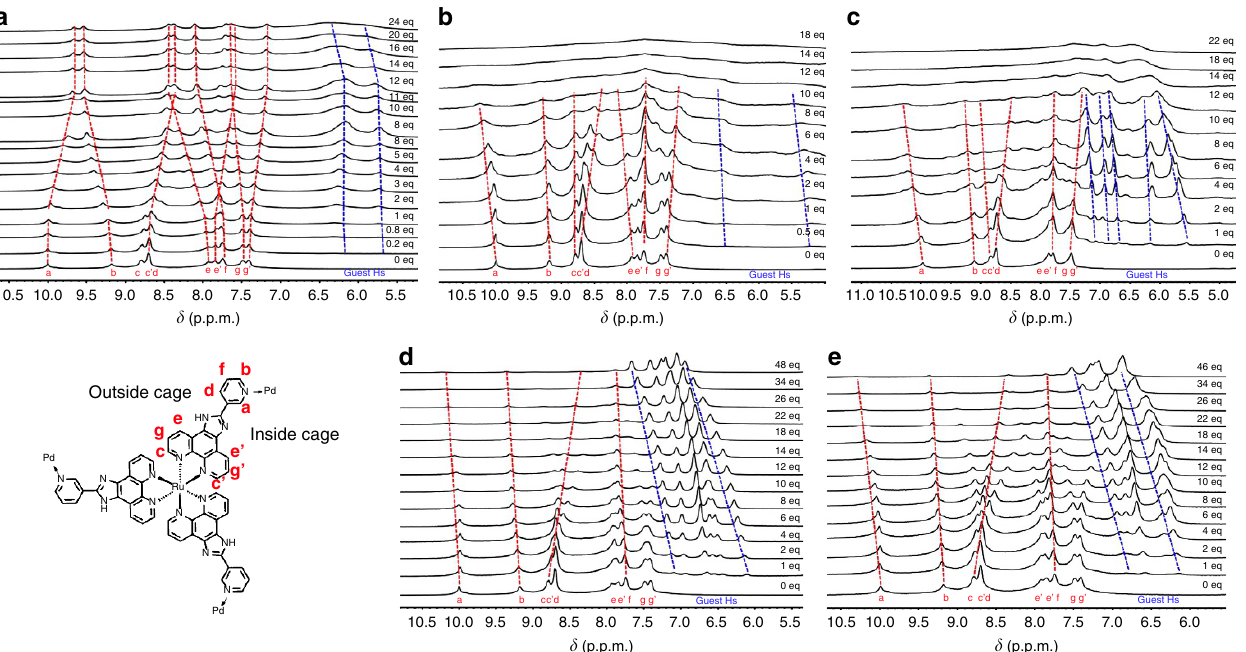
Figure 5 | 1 H NMR titration in DMSO- d 6 /D 2 O ¼ 1/5. ( a ) R -BINOL C L -MOC-16 at 298K, ( b ) S -BINOL C L -MOC-16 at 298K, ( c ) S -BINOL C L -MOC-16 at 353K, ( d ) S -1-(1-naphthyl)ethanol C L -MOC-16 at 298K and ( e ) S -1-(1-naphthyl)ethanol C D -MOC-16 at 298K.